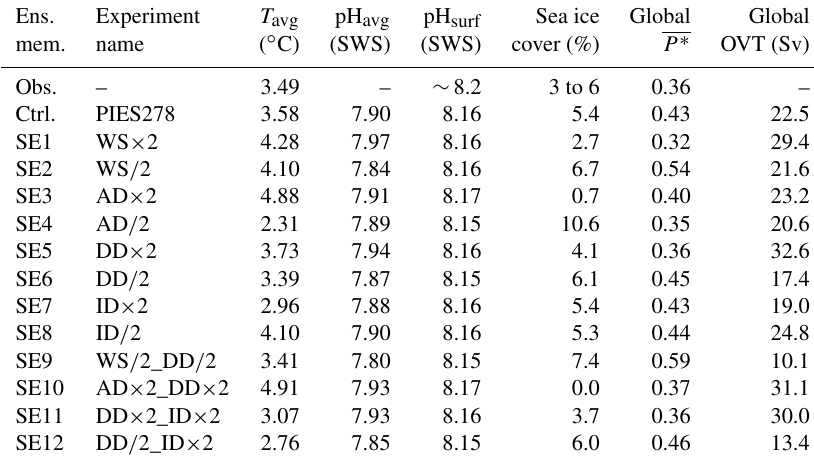
Table 3. Diagnostic variables for observations (Obs.), the control PIES278 (Ctrl.) and the ensemble members SE1–SE12. The variables are global ocean averages of temperature ( T avg , ◦ C) and pH (pH avg ), surface ocean average pH, sea ice cover (%), the global average of the nutrient utilisation efficiency (expressed in terms of P ∗ ) and a measure of the strength of the global ocean overturning circulation, OVT (see Sect. 3.4). The observational estimate for T avg has been calculated using the World Ocean Atlas 2013; Locarnini et al., 2013) and the pre-industrial estimate for pH is given by Raven et al. (2005). Modern day sea ice cover is given as an interval due to seasonal variability (Comiso, 2008). The observational estimate for P ∗ is given by Ito and Follows (2005). Ens.